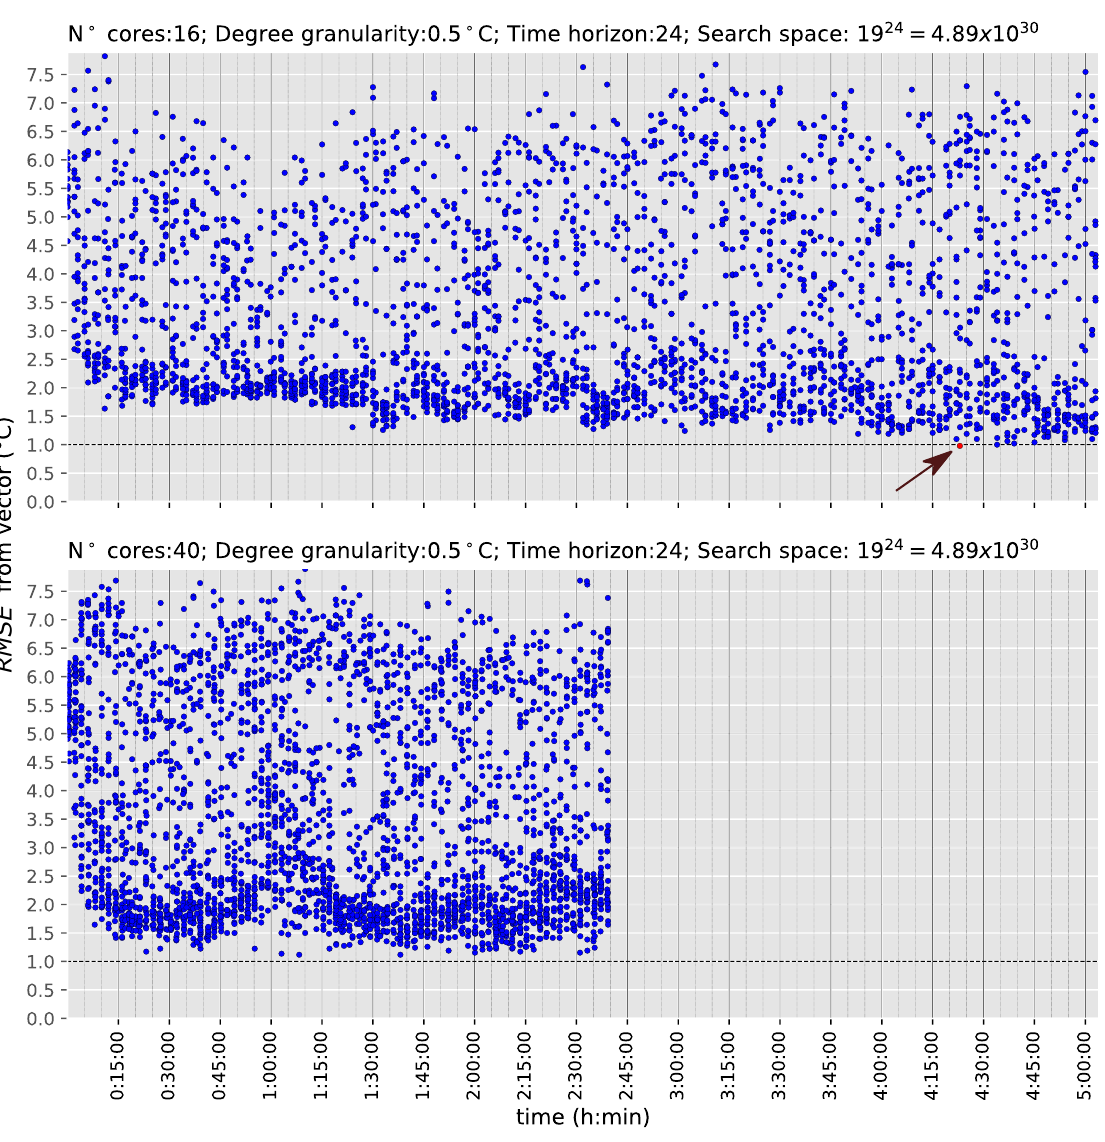
Figure 7. First experiment: MPC results without free oscillation curve consideration for search space reduction (standard computer ( top ) and workstation ( bottom